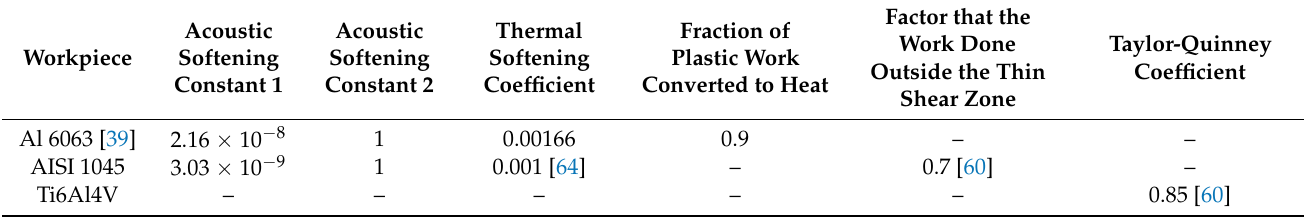
Table 6. Acoustic softening constants of workpiece and heat